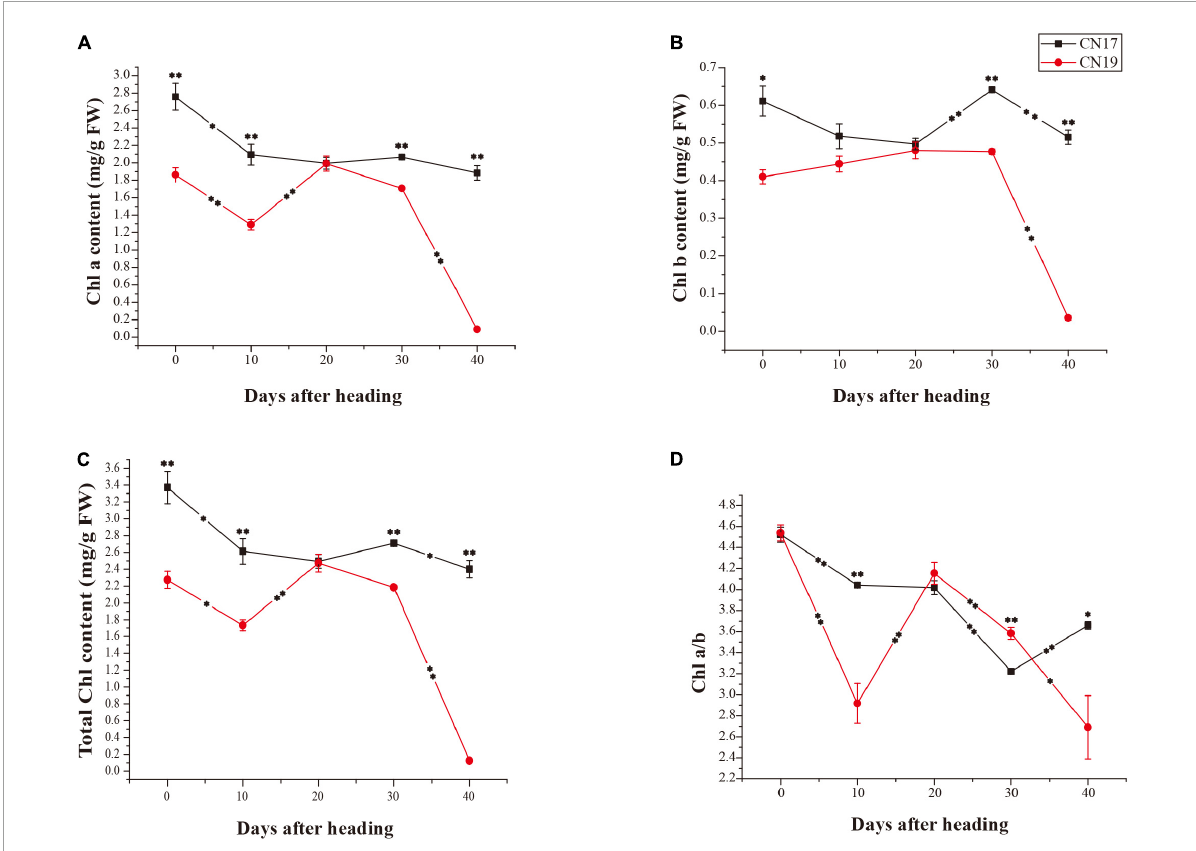
FIGURE2 Differences in Chl contents in stay-green cultivar CN17 and non-stay-green cultivar CN19 after heading. (A) Chlorophyll a (Chl a) content; (B) Chlorophyll b (Chl b) content; (C) Total chlorophyll (Chl) content; (D) Ratio of Chl a to Chl b (Chl a/b). The bars indicate the mean ± standard error ( n = 3). ∗ and ∗∗ for significant differences at P ≤ 0.05 and P ≤ 0.01, respectively; the asterisks within the lines for significant differences between adjacent time points for the same wheat cultivar; the raised asterisks for significant differences between genotypes at each time point; FW for fresh